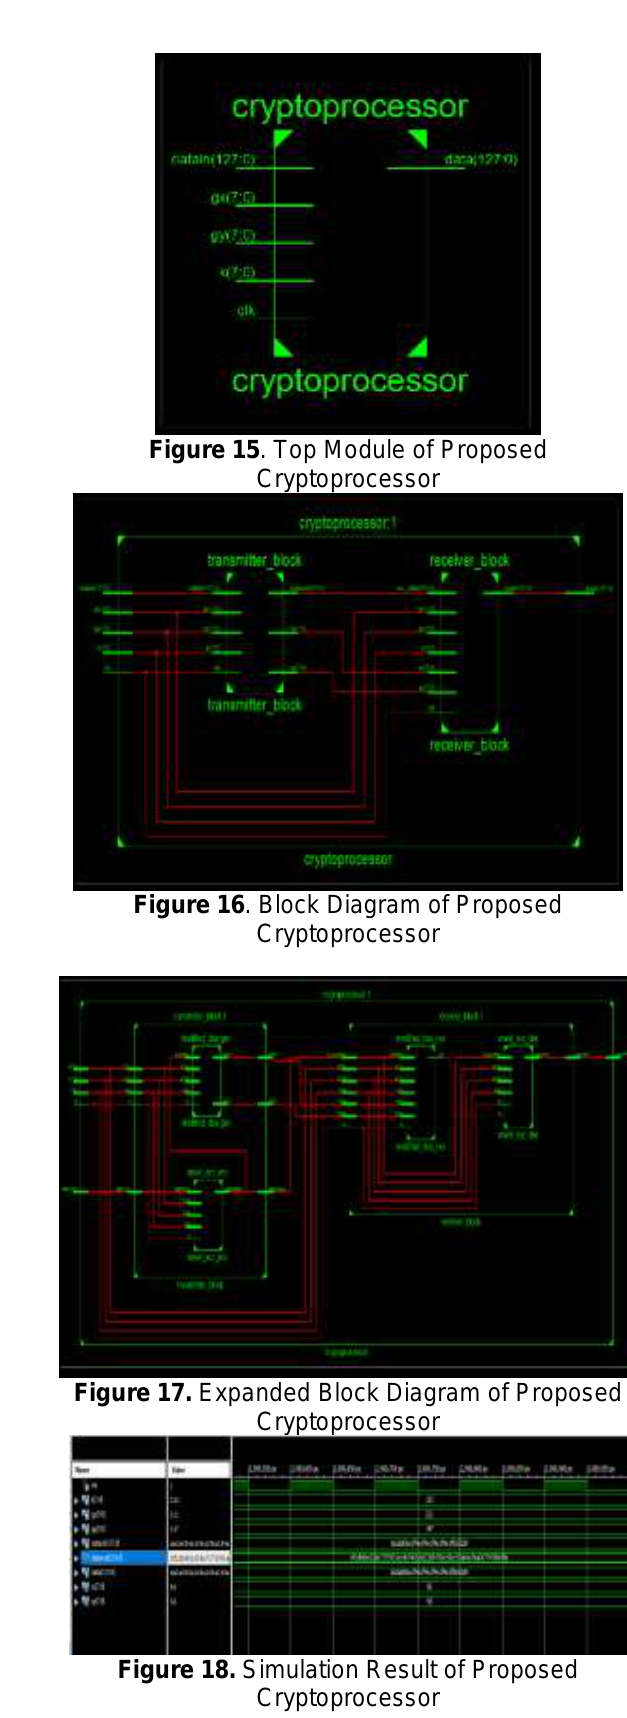
Figure 18. Simulation Result of Proposed